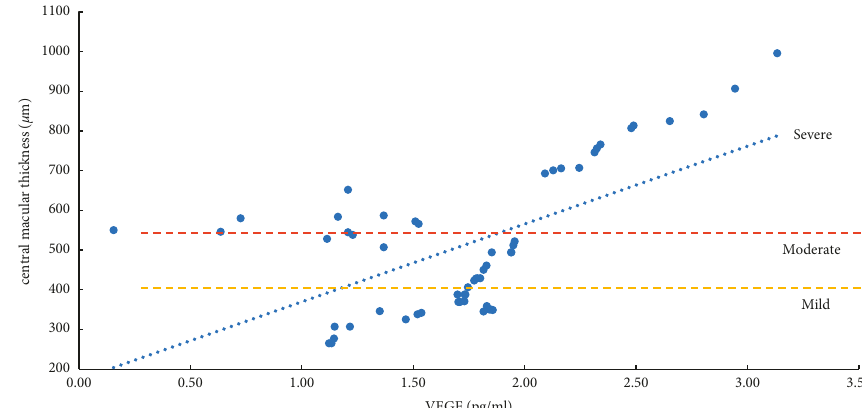
Figure 2: Correlation analysis of ME with a mild, moderate, and severe degree and IL-6 (interleukin-6).